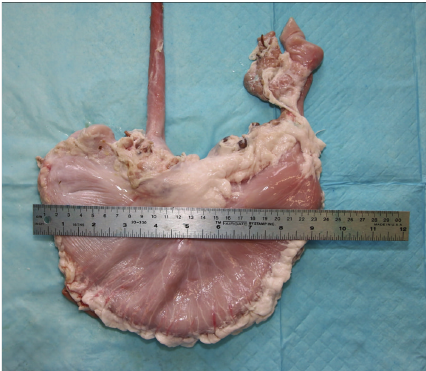
Figure 1: Measurement of horizontal length of